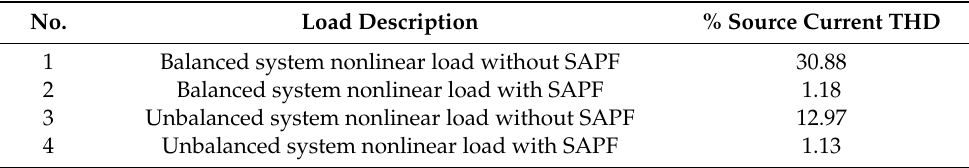
Table 3. %THD comparison. Method